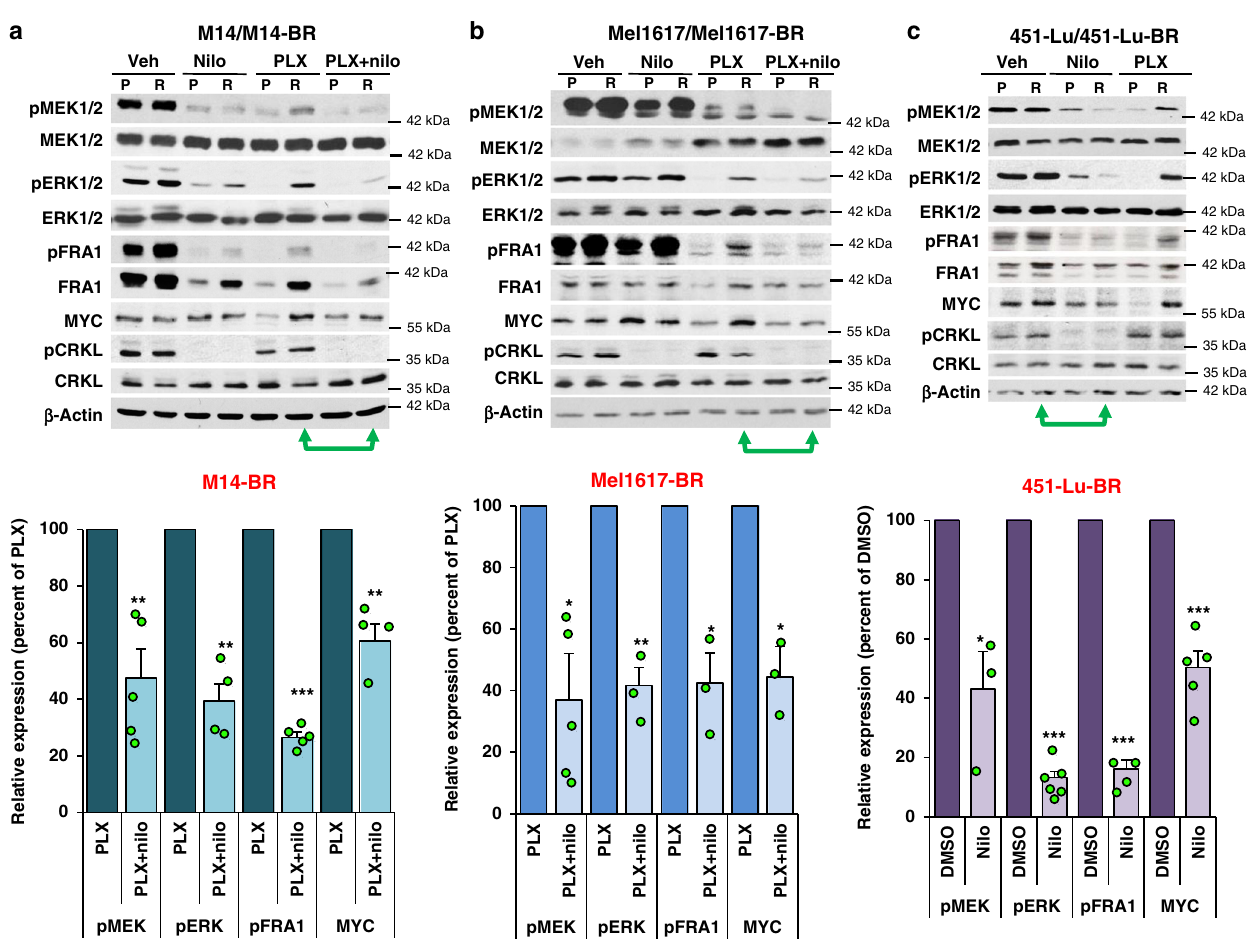
Fig. 4 Nilotinib blocks reactivation of ERK signaling in BRAFi-resistant cells. BRAFi (-BR; R) or parental (P) cells were treated with vehicle, nilotinib (nilo; 2.5 μ M), PLX4720 (M14 and 451-Lu 1 μ M; Mel1617 2.5 μ M) or the combination for 24 h, and the resulting lysates probed with the indicated antibodies. Quantitation of key signaling molecules for n = 3 – 5 independent experiments is shown below blots; green arrows indicate lanes quanti fi ed. Mean ± SEM is shown. M14-BR : pMEK n = 5, pERK n = 4, pFRA1 n = 5, MYC n = 4. Mel1617-BR : pMEK n = 5, pERK n = 3, pFRA1 n = 3, MYC n = 3. 451-Lu-BR : pMEK n = 3, pERK n = 6, pFRA1 n = 4, MYC n = 5. For M14 and Mel1617 cell lines, data are a comparison between PLX + nilotinib vs. PLX lanes, whereas for 451-Lu cell lines, nilotinib alone is compared to vehicle (DMSO). * p < 0.05, ** p ≤ 0.01, *** p < 0.001 using one-sample t -tests (two-sided). Actual p values (left → right): a 0.0069, 0.002, <0.0001, and 0.0072. b 0.026, 0.0097, 0.029, and 0.011. c 0.046, <0.0001, 0.00011, and 0.0001. pCRKL (substrate of ABL1/2) is an indirect read-out of ABL1/2 activity and indicates the ef fi ciency of nilotinib-mediated inhibition. For all experiments, BRAFi-resistant lines were maintained in PLX (1 μ M), but were cultured for 2 days without PLX prior to plating for experiments.